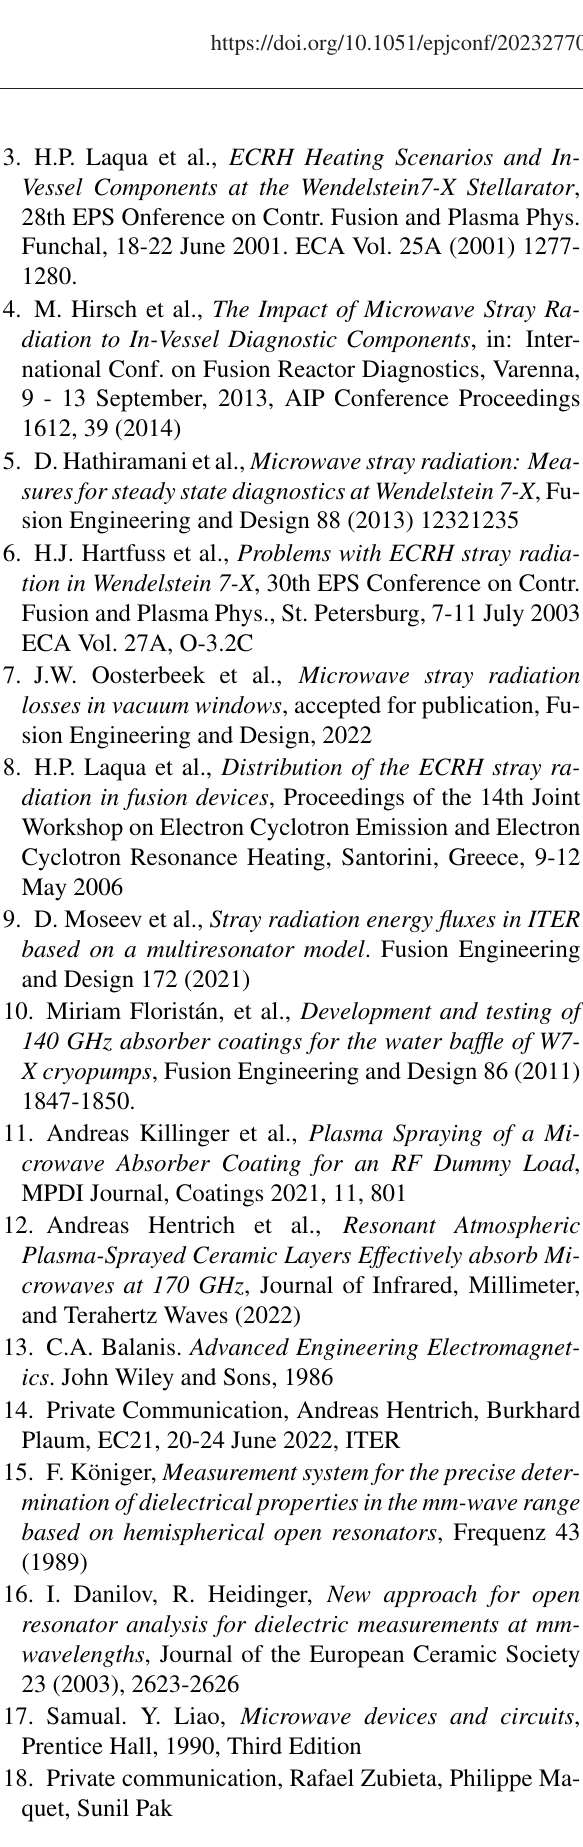
Figure 12. Heating rate of the ITER window